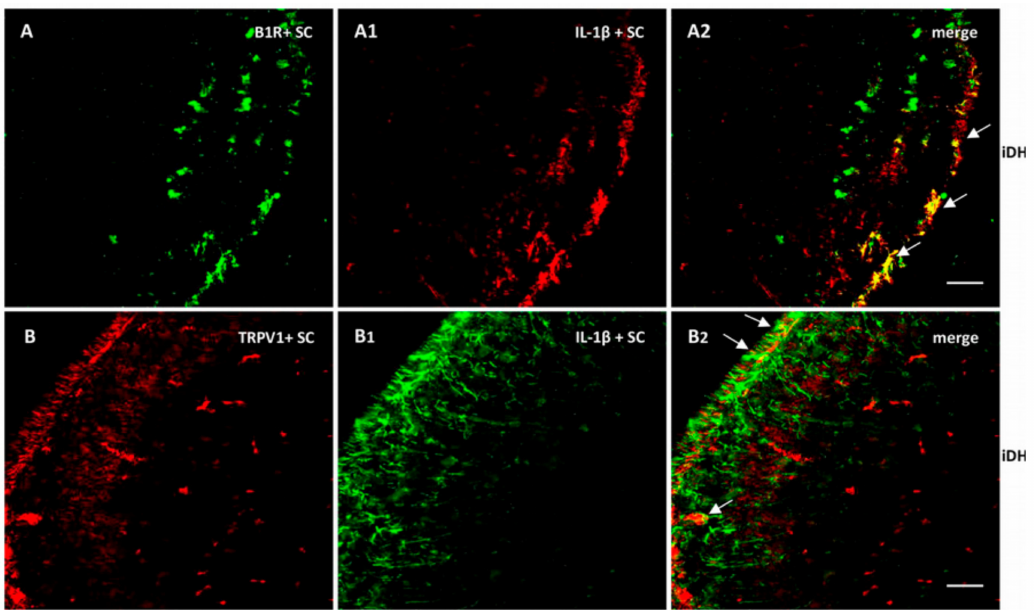
Figure 9. Distribution of B1R and TRPV1 in relation with IL-1 β in the ipsilateral Dorsal Horn (iDH). Representative microphotographs by immunofluorescence of B1R (green, A ) and IL-1 β (red, A1 ) in the spinal cord of PSNL rats. Image A2 shows colocalization between B1R and IL-1 β (yellow spots). Likewise, TRPV1 (red, B ) and IL-1 β (green, B1 ) colocalize ( B2 ) in the superficial layers of the spinal cord of PSNL rats. However, this colocalization is sparsely expressed. Scale bar = 120 µ m. Magnification 10 ×